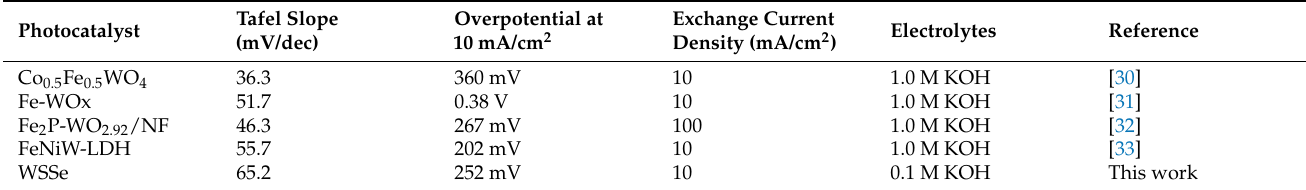
Figure 5. H 2 evolution of ( a ) WS 2 , WSe 2 , and WSSe-3 and H 2 production comparison of ( b ) WSSe-1, WSSe-2 and WSSe-3. ( c ) H 2 production with various usage amounts of WSSe-3. ( d ) H 2 production of the cycling performance, ( e ) XRD analysis of WSSe-3 before and after the hydrogen production activity. (The error bars represent results of three duplicates.). Table 2. Studies of the tungsten-based photocatalysts for the hydrogen production.